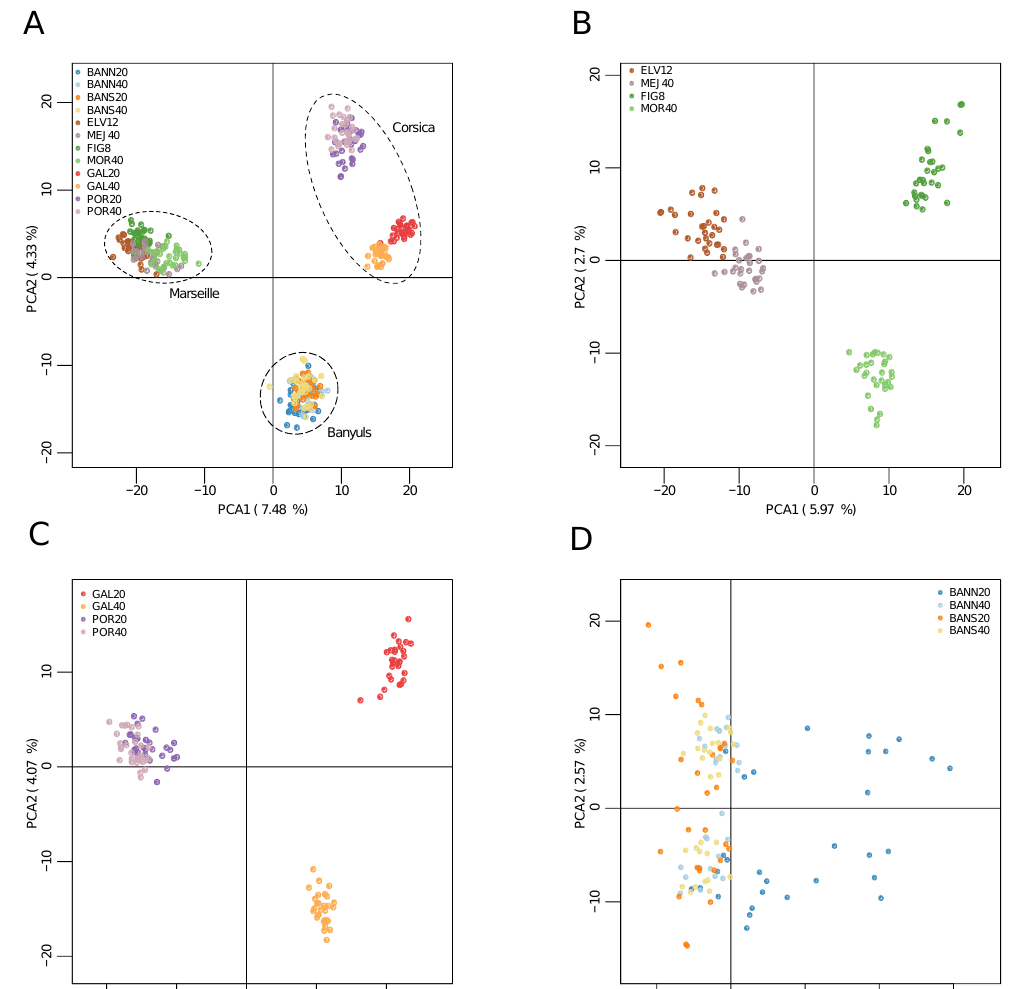
Figure S2. Principal component analysis (Axes 1 and 2), using only putative neutral SNPs, of the A) 12 red coral populations (n = 354 individuals, 25 669 SNPs), B) four red coral populations from Marseille (n =119 individuals, 26 898 SNPs), C) four red coral populations from Corsica (n =117 individuals, 26 592 SNPs), D) four red coral populations from Banyuls (n =118 individuals, 27 069